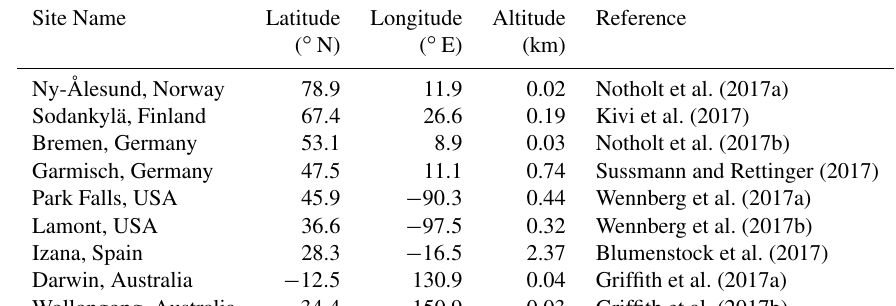
Table 3. TCCON sites (Wunch et al., 2011) used for evaluation of the TOMCAT simulations.